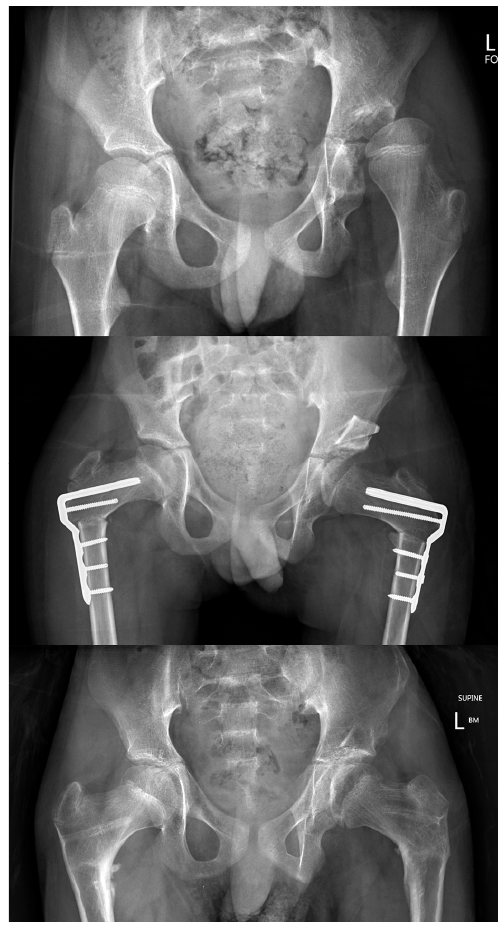
Figure 7. Bilateral surgery for unilateral CPHD. Copyright Kerr Graham, RCH Melbourne. These are the radiographs of a boy aged 10 years, GMFCS IV with clinical and radiographic unilateral (left) CPHD. The top image is immediately pre-operative. The middle image is 7 days after bilateral APR, bilateral VDRO and left San Diego Acetabuloplasty. The bottom image is at 2-year follow-up, after removal of implants. Bilateral surgery gives the best opportunity for symmetry and durability of outcome with marginal increases in surgical adverse events and